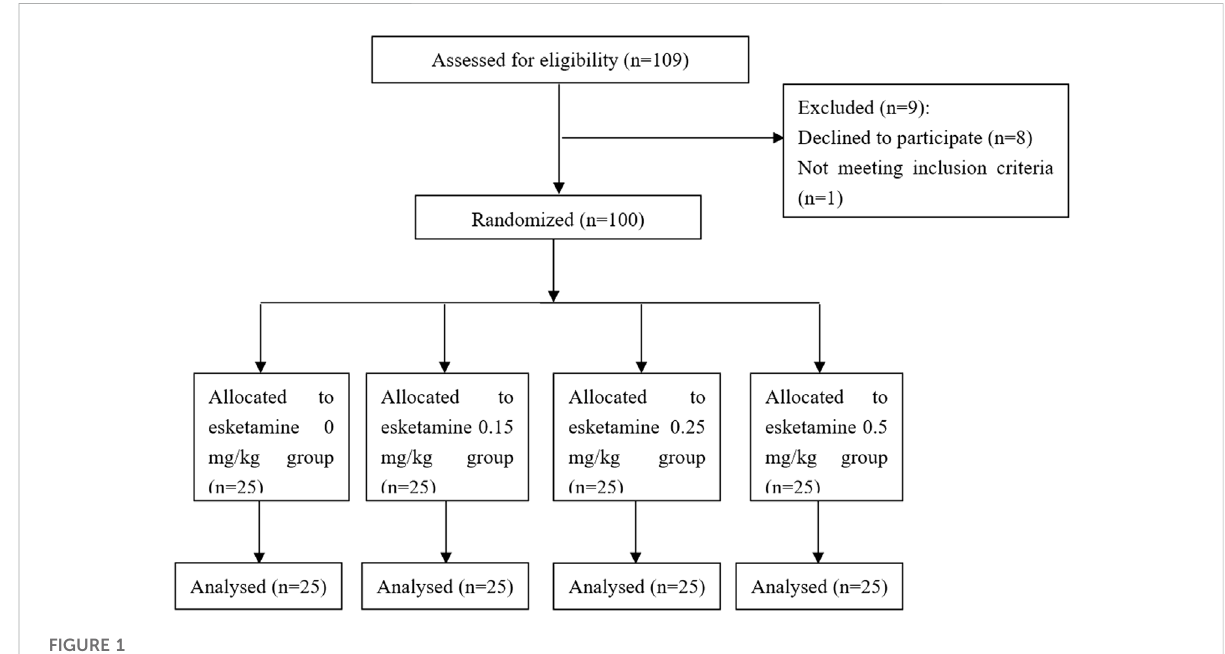
FIGURE 1 Flow diagram of included participants.